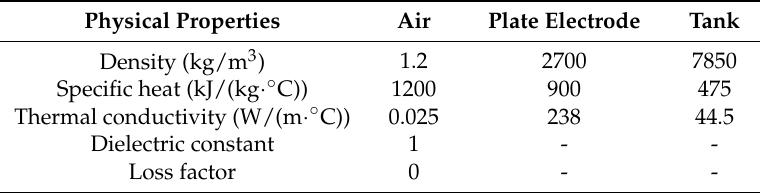
Table 1. The physical properties of the material in the